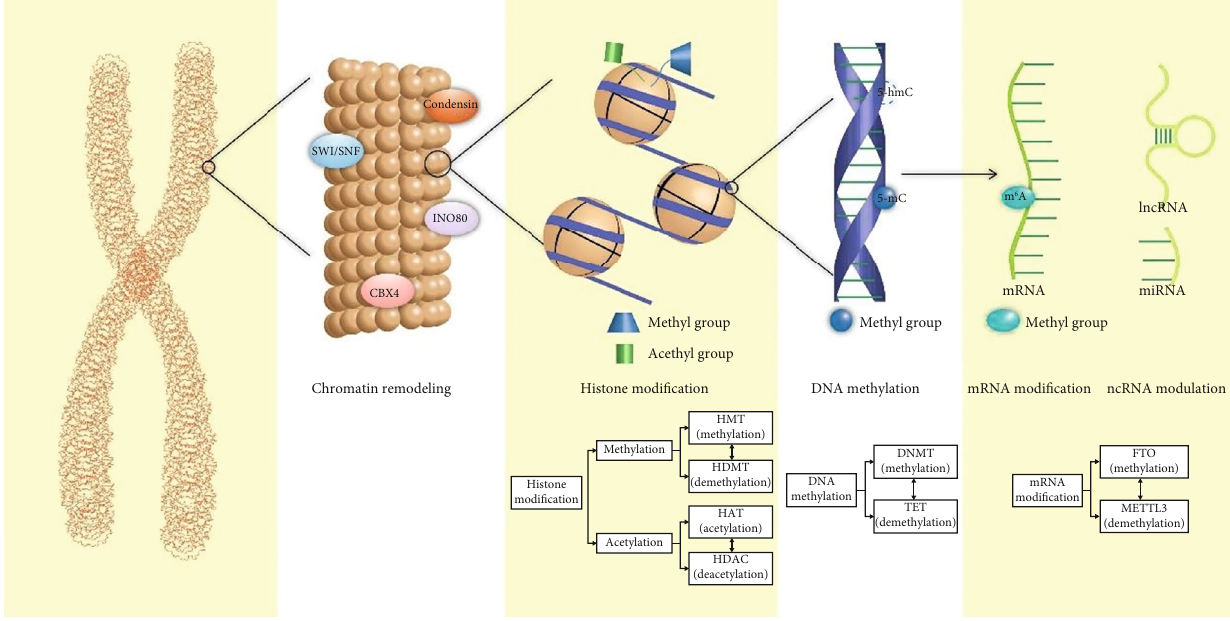
Figure 1: Factors in epigenetic regulation. Epigenetic regulation occurs in several steps of transcription (such as chromatin remodeling, DNA methylation, and histone modi fi cation) and posttranscription (such as mRNA processing and ncRNA regulation). Speci fi c regulatory factors participate in each process. Table 1: DNA methylation in MSC aging and related